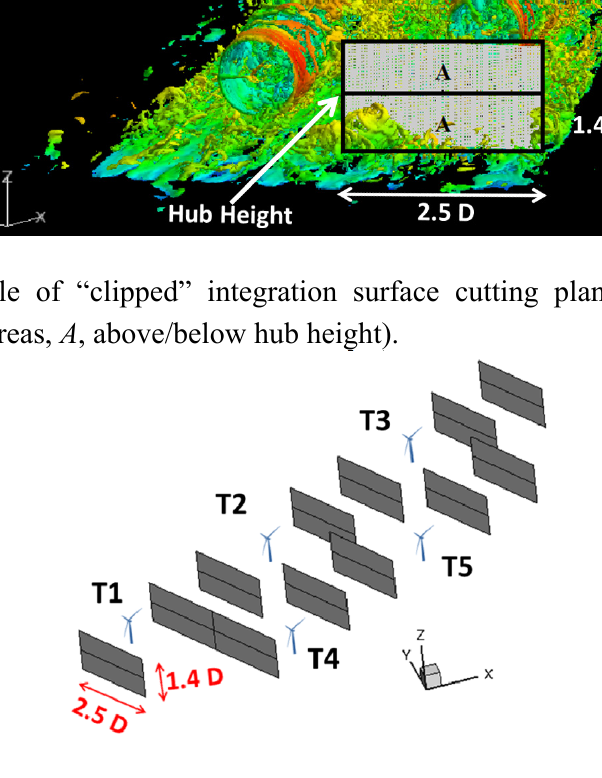
Figure 20. Locations of “clipped” integration surface cutting planes in 5-Turbine Wind Farm. (For clarity, not all integration planes are